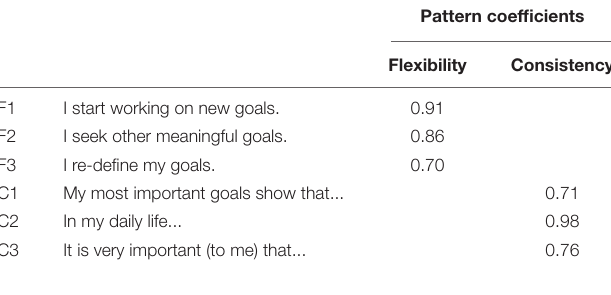
TABLE 3 | Study 2: Pattern matrix from confirmatory factor